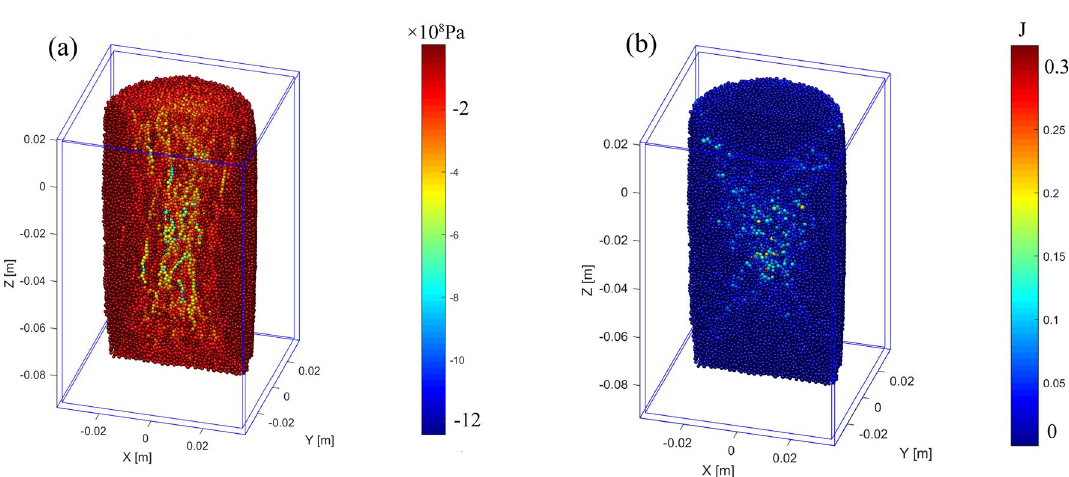
Figure 12. The stress field and slipping frictional heat field at strain 8.5% under 2 MPa confining pressure: ( a ) stress field; ( b ) slipping frictional heat